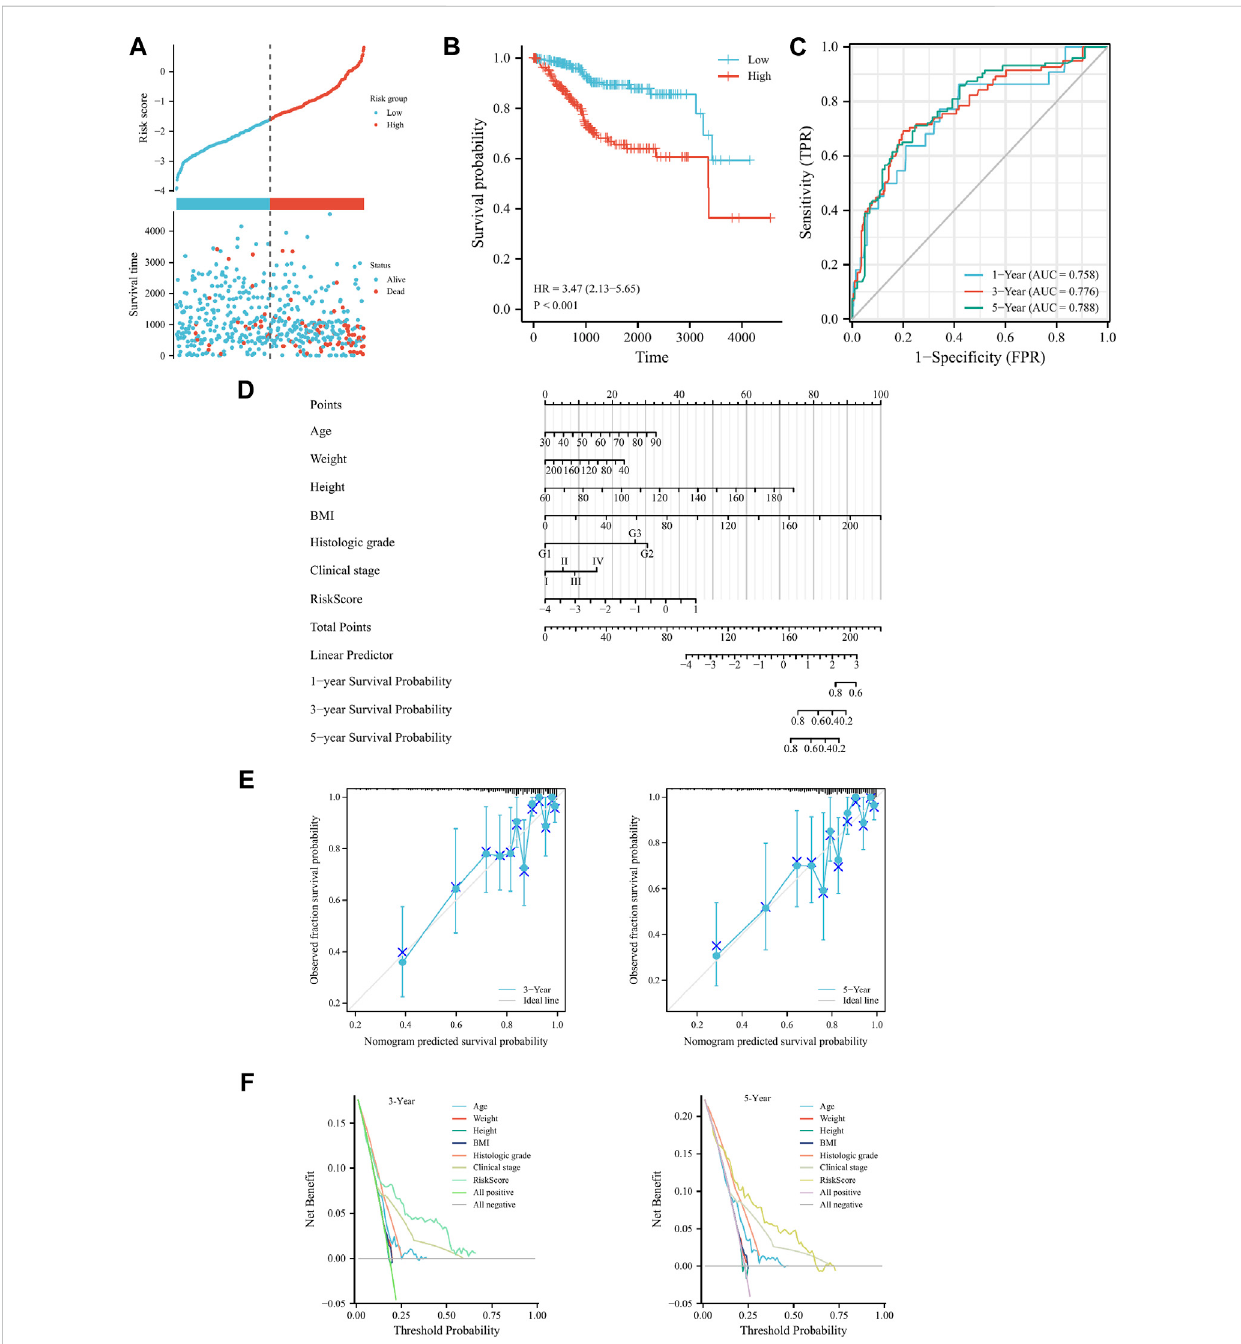
FIGURE 4 Cervical cancer FRGsprognosis model validation in the TCGA-UCEC. (A) Curve scatter plotof validation setsurvival model ef fi cacy assessment and cumulative scatter plot of survival mortality event risk. (B) KM curve shows that there is a signi fi cant difference in OS between high-risk and low-risk groupsinTCGA-UCEC. (C) Time-dependentROCcurveswereusedtopredict1,3,and5 yearssurvival. (D) 1,3and5 yearsnomogramsforpredictingOS in TCGA-UCEC. (E) Calibration curves showing the agreement between predicted and observed 3 and 5 years OS. (F) Decision curve analysis of the prognostic model in the validation set at 3 and 5